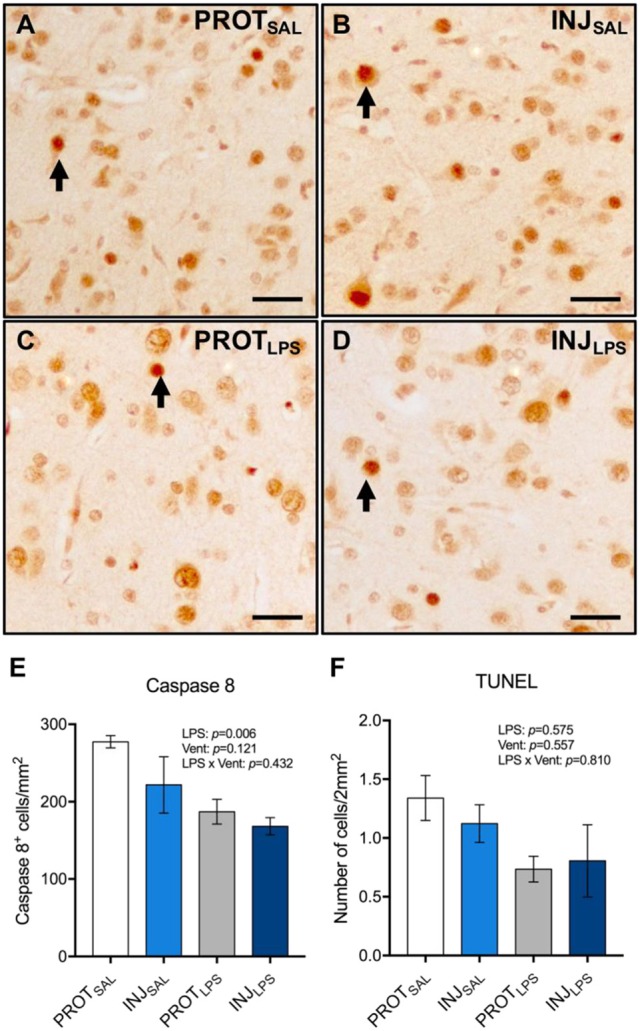
Ventilation strategy and LPS exposure did not induce apoptosis in cortical gray matter. Representative images of Caspase 8+ cells in the gray matter (A–D). A significant reduction in the number of Caspase 8+ cells was observed in the LPS-treated groups compared to the respective saline controls (E). No significant differences in the number of TUNEL+ cells were observed between the groups (F). Magnification = 8x, scale bar = 20 μm. PROTSAL, N = 5; PROTLPS, N = 6; INJSAL, N = 6; and INJLPS, N = 5.